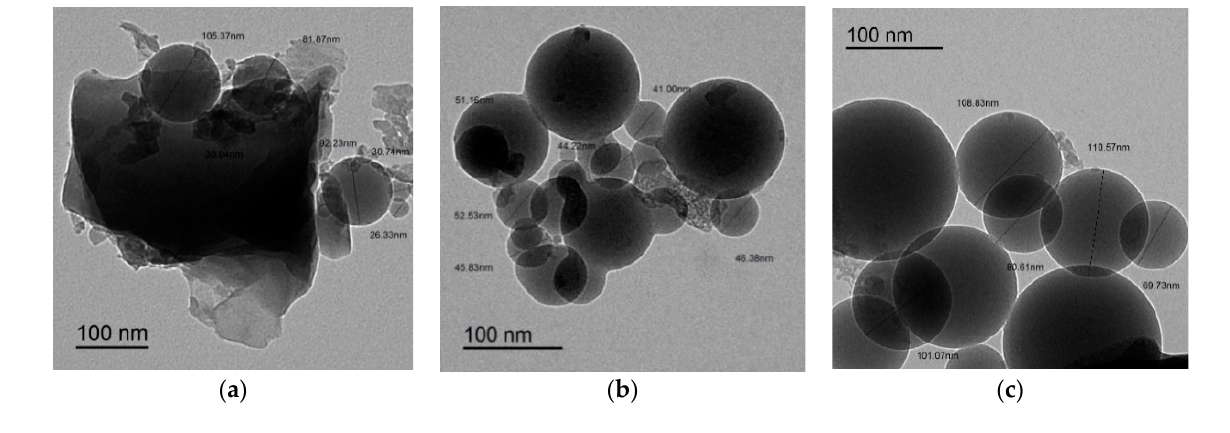
Figure 1. Particle size distributions of ASMs.